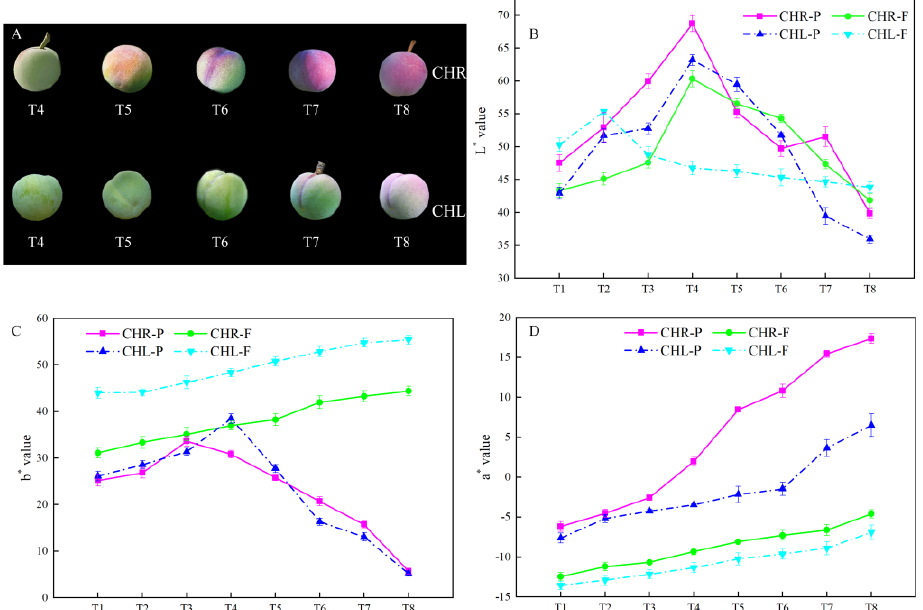
Figure 2. Changes in color during plum development. ( A ) Photographs of T4 to T8 development stages of CHL and CHR; ( B ) Fruit L* value, L* represents brightness; ( C ) Fruit b* value, b* represents yellow–blue difference; ( D ) Fruit a* value, a* represents the red–green difference. CHR-P and CHL-P represent the skin of ‘Cuihongli Red’ and ‘Cuihongli’, respectively. CHR-F and CHL-F represent the flesh of ‘Cuihongli Red’ and ‘Cuihongli’, respectively, the same as below. Each value is the mean for three replicates. The vertical bar indicates the standard error.